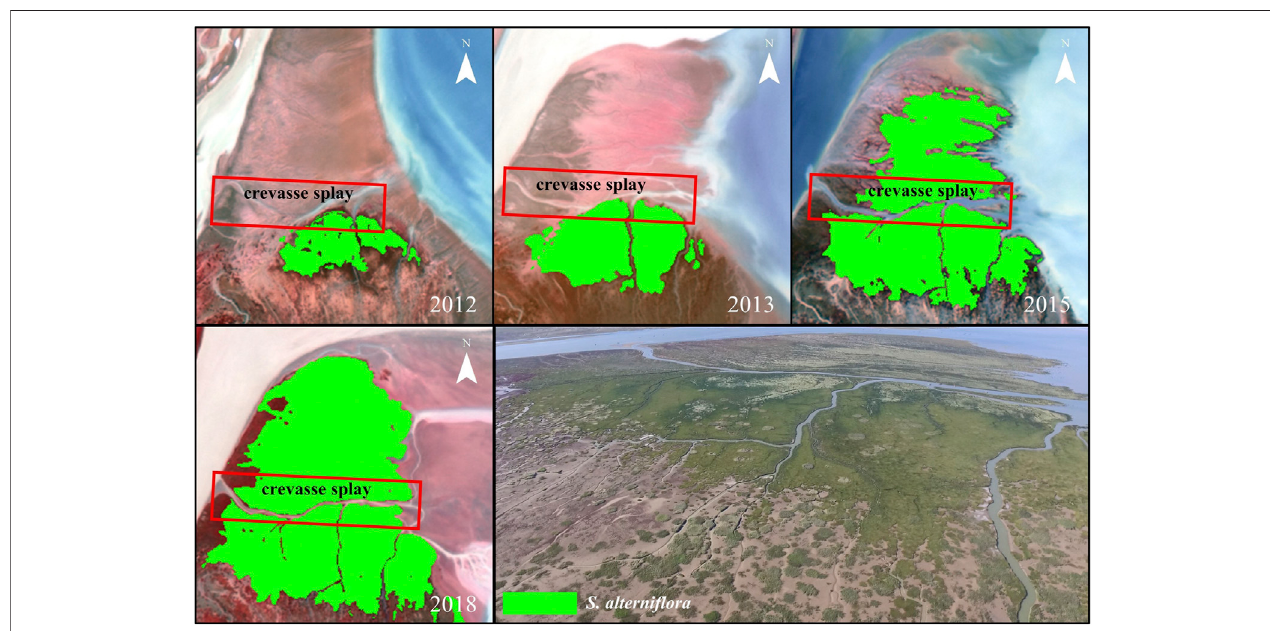
FIGURE 9 | Landsat 7/8 remote sensing images acquired in September 24, 2012, September 19, 2013, September 25, 2015 and September 17, 2018, and fi eld observation image acquired in 2018.09 showing S. alterni fl ora invading along the crevasse splay in sub-region d at the Yellow River Estuary. Photo credit: X. Ma.